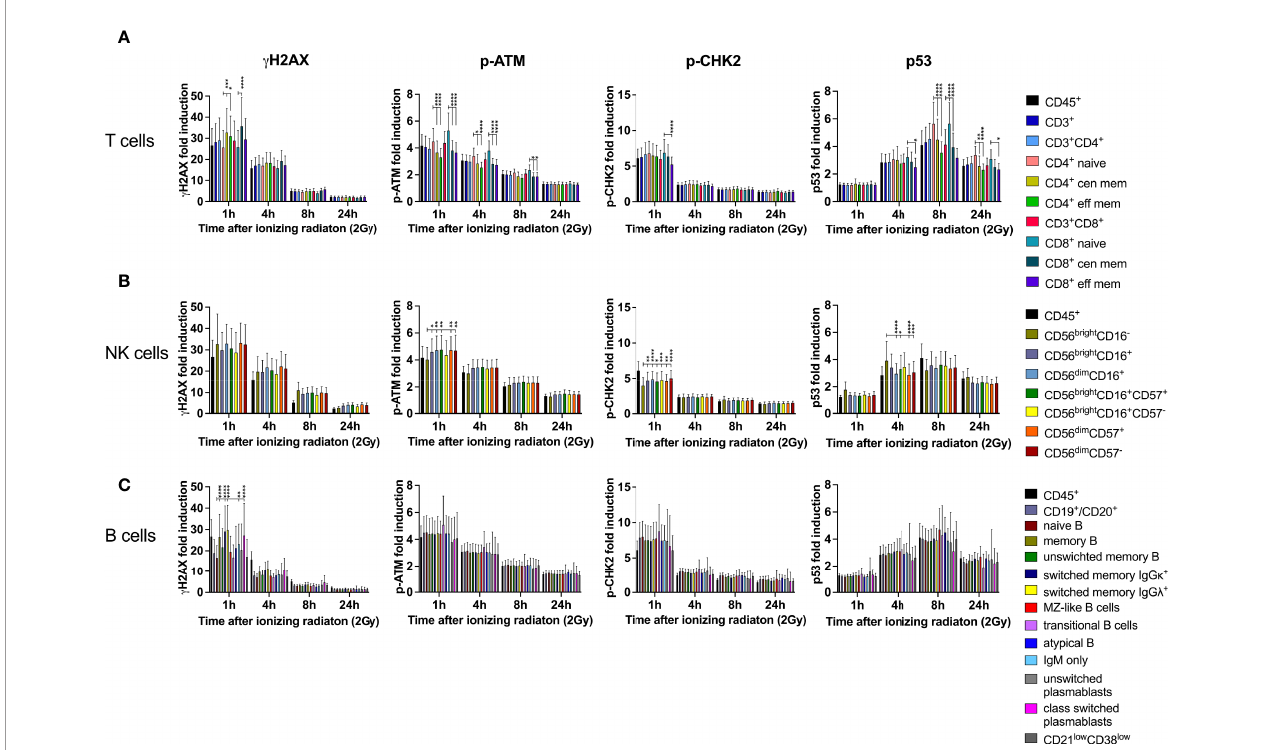
FIGURE 3 | DDR in naïve lymphocyte subsets is differential to mature memory populations. PBMCs obtained from 26 healthy donors were irradiated with 2Gy and fi xed at indicated time points. Surface markers of lymphocyte subsets and intranuclear DDR biomarkers were assessed by mass cytometry. Fold inductions of g H2AX, p-ATM, p-CHK2, and p53 were calculated in CD45 + lymphocyte subsets, based on mean fl uorescence intensities normalized on unirradiated samples. T cell subsets were characterized as CD3 + , CD3 + CD4 + , CD3 + CD8 + , CD45RA + CCR7 + (naïve CD4/CD8), CD45RO + CCR7 +/- (central and effector memory CD4/CD8) (A) . NK lymphocyte subsets were de fi ned as CD3 - CD56 bright CD16 - , CD3 - CD56 bright CD16 + , CD3 - CD56 dim CD16 + (B) , which were further strati fi ed to CD57 expression on CD56 bright CD16 + and CD56 dim CD16 + subsets. CD3 - B lymphocytes were characterized as CD19 + CD20 + , CD27 - IgD + (naïve B), CD27 + (memory B), CD27 + IgM + (unswitched memory B) CD27 + IgM - IgG k + (class switched memory B IgG k ), CD27 + IgM - IgG L + (class switched memory B IgG L ), CD27 + IgM + IgD + (Marginal Zone (MZ)-like B), IgM ++ CD38 ++ (transitional B), CD27 + IgM + IgD - (IgM only B), CD27 - IgM - IgD - (atypical memory B), CD19 + CD20 - CD27 + CD38 + IgM + (unswitched plasmablasts), CD19 + CD20 - CD27 + CD38 + IgM - (class switched plasmablasts), and CD21 low CD38 low B cells. (C) Bars represent mean values of fold induction; error bars represent standard deviations. Signi fi cance is shown for naïve T and B cell subsets compared to memory subsets, and immature CD56 bright CD16 - to mature CD56 bright CD16 + and CD56 dim CD16 + NK lymphocytes (*p ≤ 0.05, **p ≤ 0.01, ***p ≤ 0.001, ****p ≤